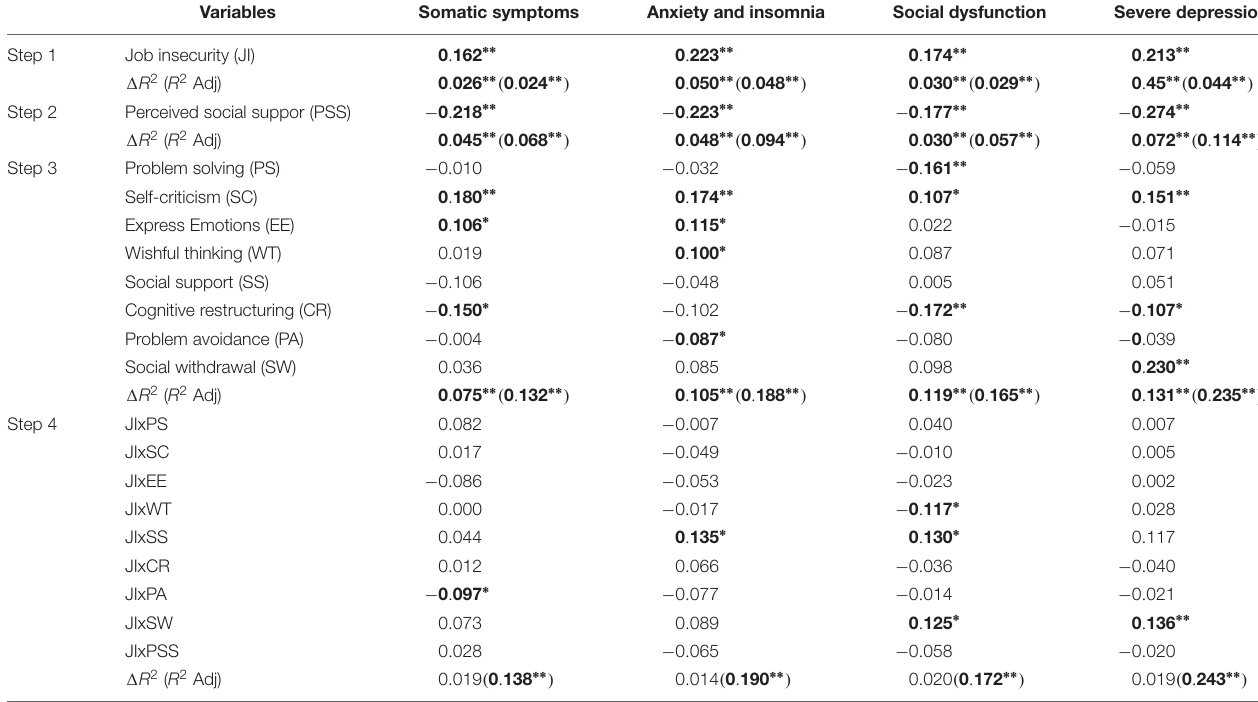
TABLE 4 | Results of hierarchical regression analysis for job insecurity. Variables Somatic symptoms Anxiety and insomnia Social dysfunction Severe